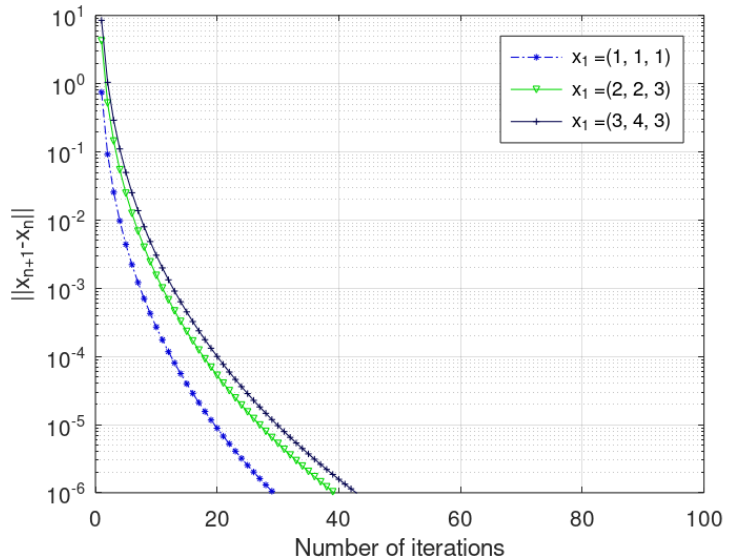
Figure 2. Convergence graph of (cid:107) x n + 1 − x n (cid:107) . Table 1. Comparison table of Figures 1 and 2.